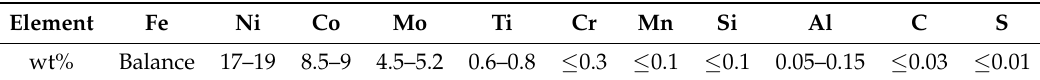
Table 2. Chemical composition of the steel powder used in this study in percentage by mass (wt%) per element according to